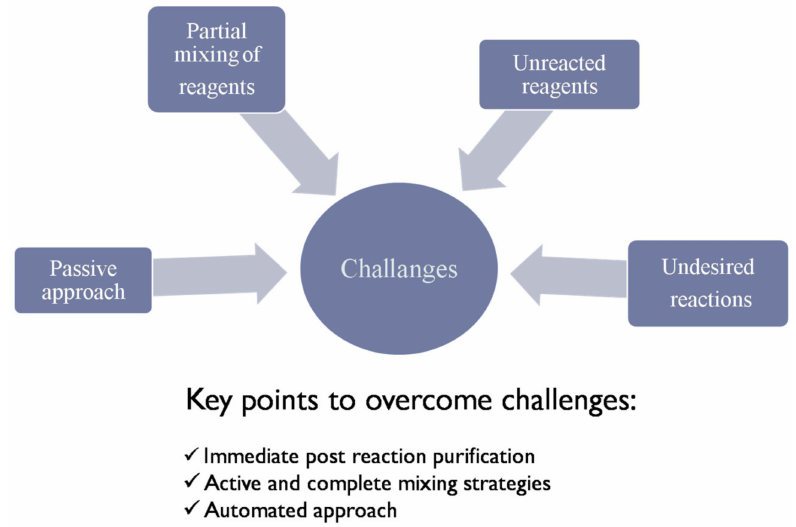
Figure 2. Challenges and key points in reproducible synthesis of